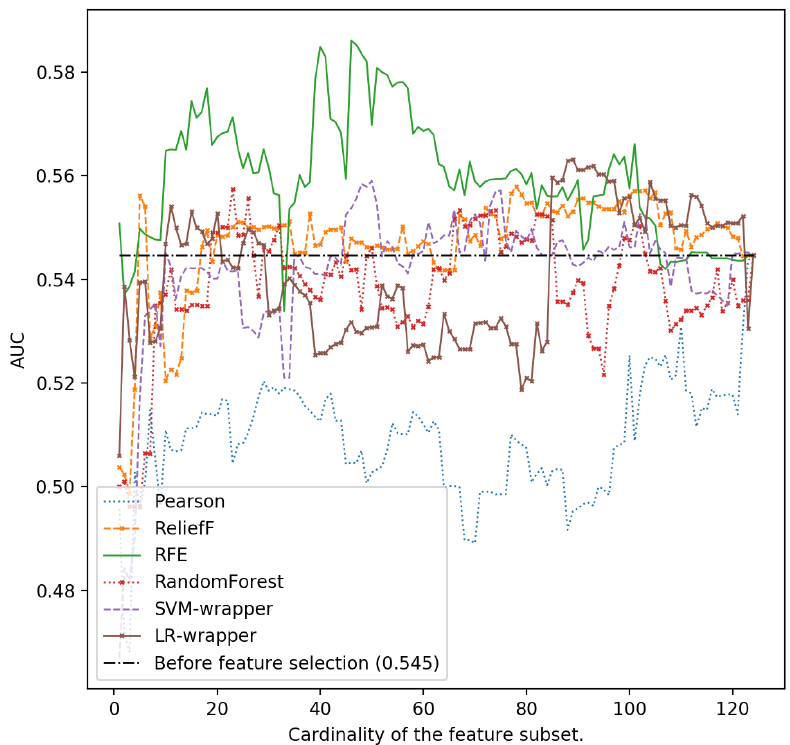
Figure 2. Area under the curve using the complete data set without reducing features and different cardinality of the subset of features for different classifiers: k-NN.